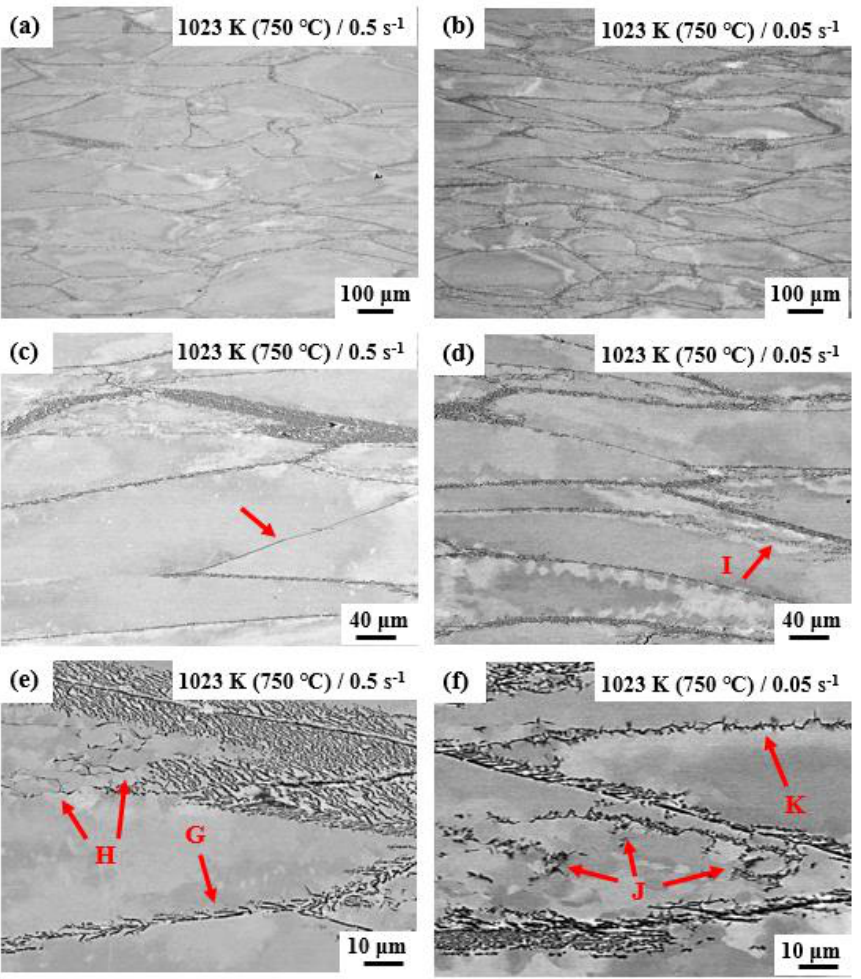
Figure 8. Deformed microstructures at 1023 K (750 °C) for the strain rates of 0.5 s −1 ( a , c , e ) and 0.05 s −1 ( b , d , f ). Here, ( c , e ) are the enlarged areas in ( a , d , f ) are the enlarged areas in ( b ).